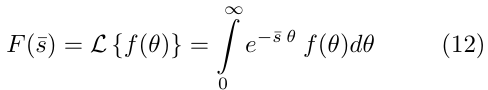
Fig. 11. Both responses for a machine with 5 cylin-